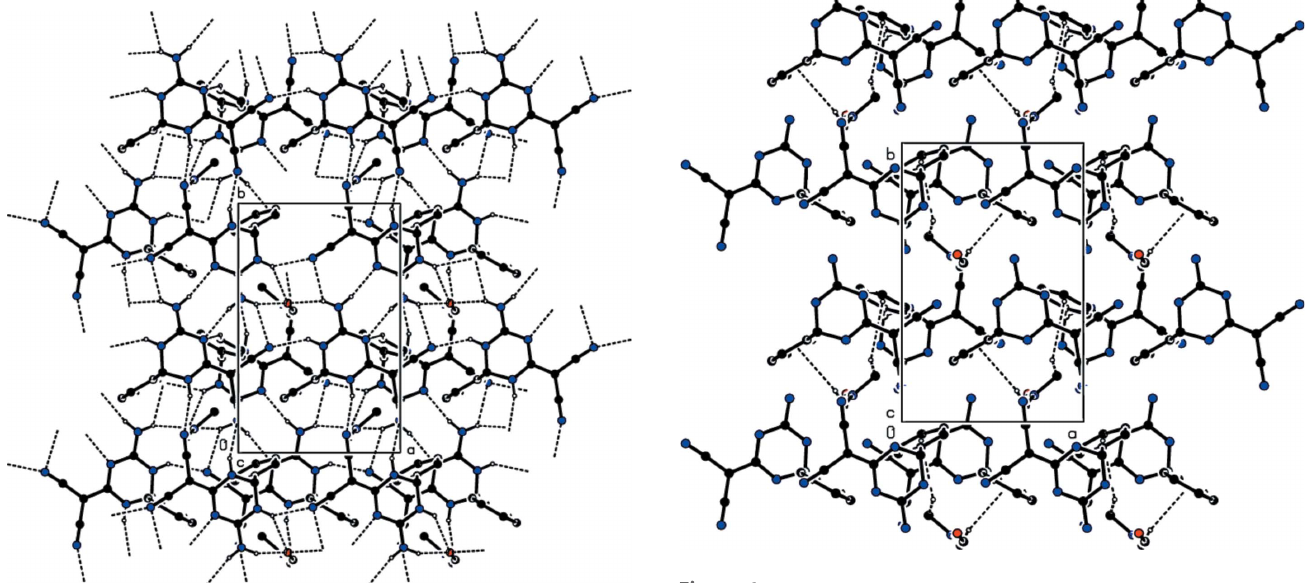
Figure 6 A partial view down the c axis of the C—H (cid:2)(cid:2)(cid:2) (cid:2) interactions (dashed lines) in the title compound. The minor disordered components and hydrogen atoms not involved in hydrogen bonding have been omitted for